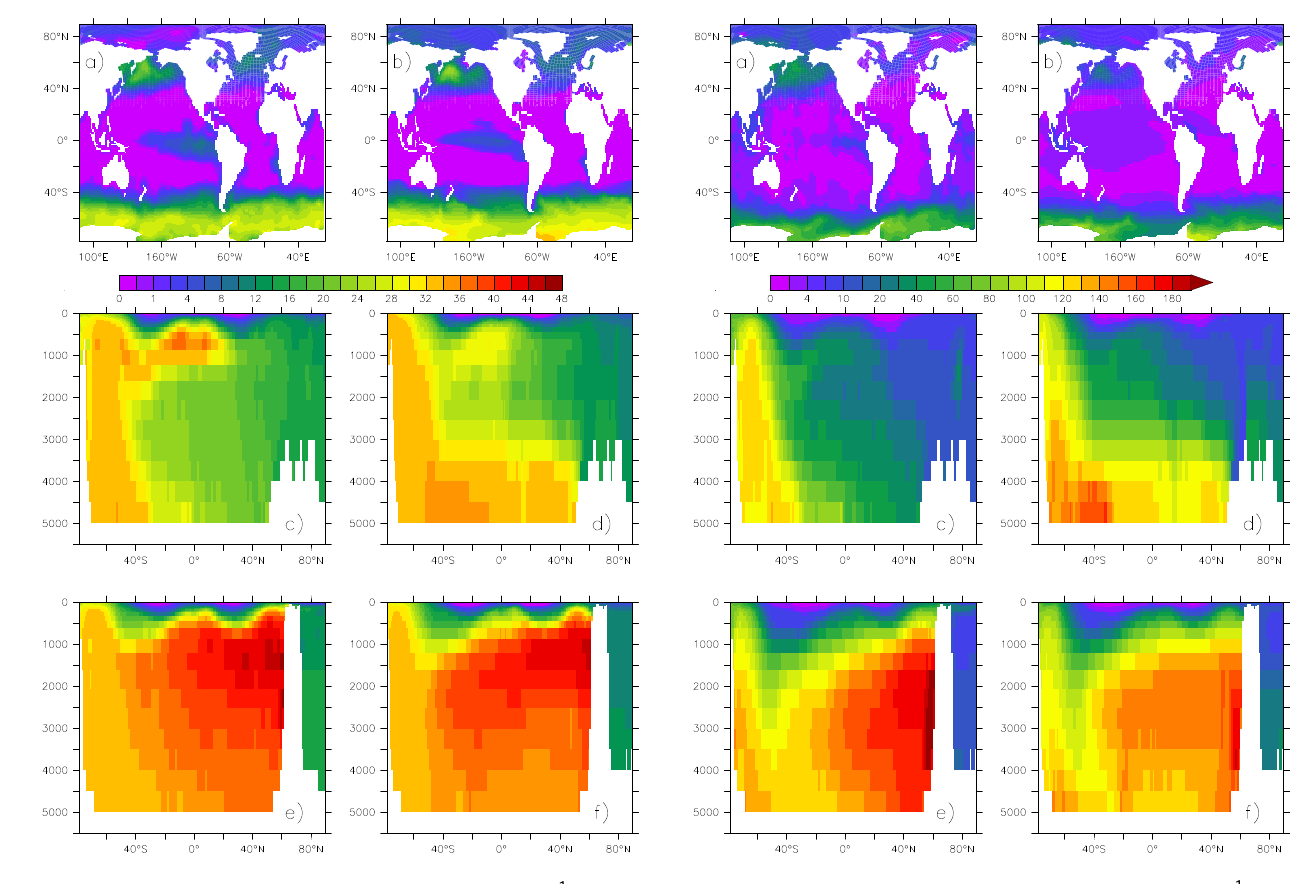
Figure 9. Annual-mean NO 3 concentrations in µmolNL − 1 . Obser- vations are from the World Ocean Atlas 2009 (Garcia et al., 2010). (a) Observed surface. (b) Model run surface. (c) Observed tran- sect zonally averaged over the Atlantic. (d) Same as (c) but for the model. (e) Observed transect zonally averaged over the Pacific. (f) Same as (e) but for the model.